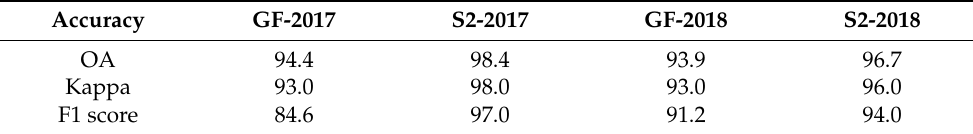
Table 7. The accuracy of the classified results from GF-1 and S-2 for the two years.